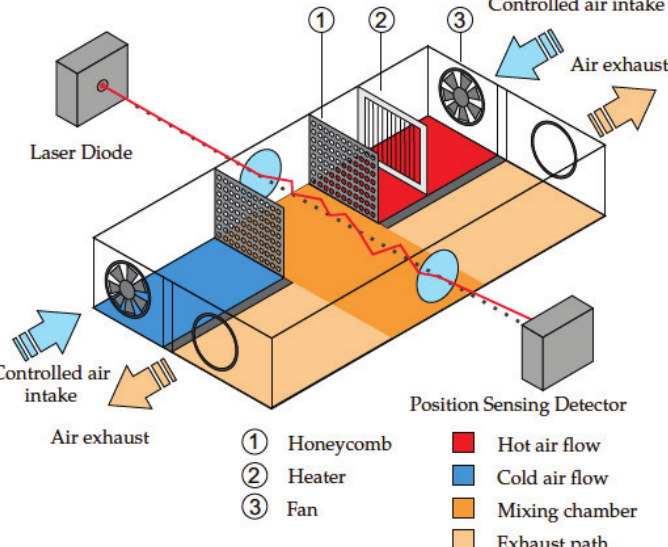
Figure 5. The schematic diagram of a turbulator used for non-classic turbulence simulations. Reprinted with permission from Reference [48].